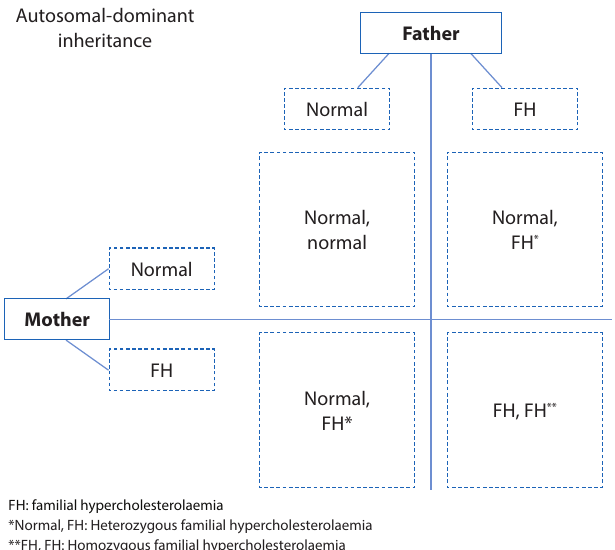
Figure 1 : The mode of inheritance of familial hypercholesterolaemia, showing both the heterozygous and homozygous forms of the disease